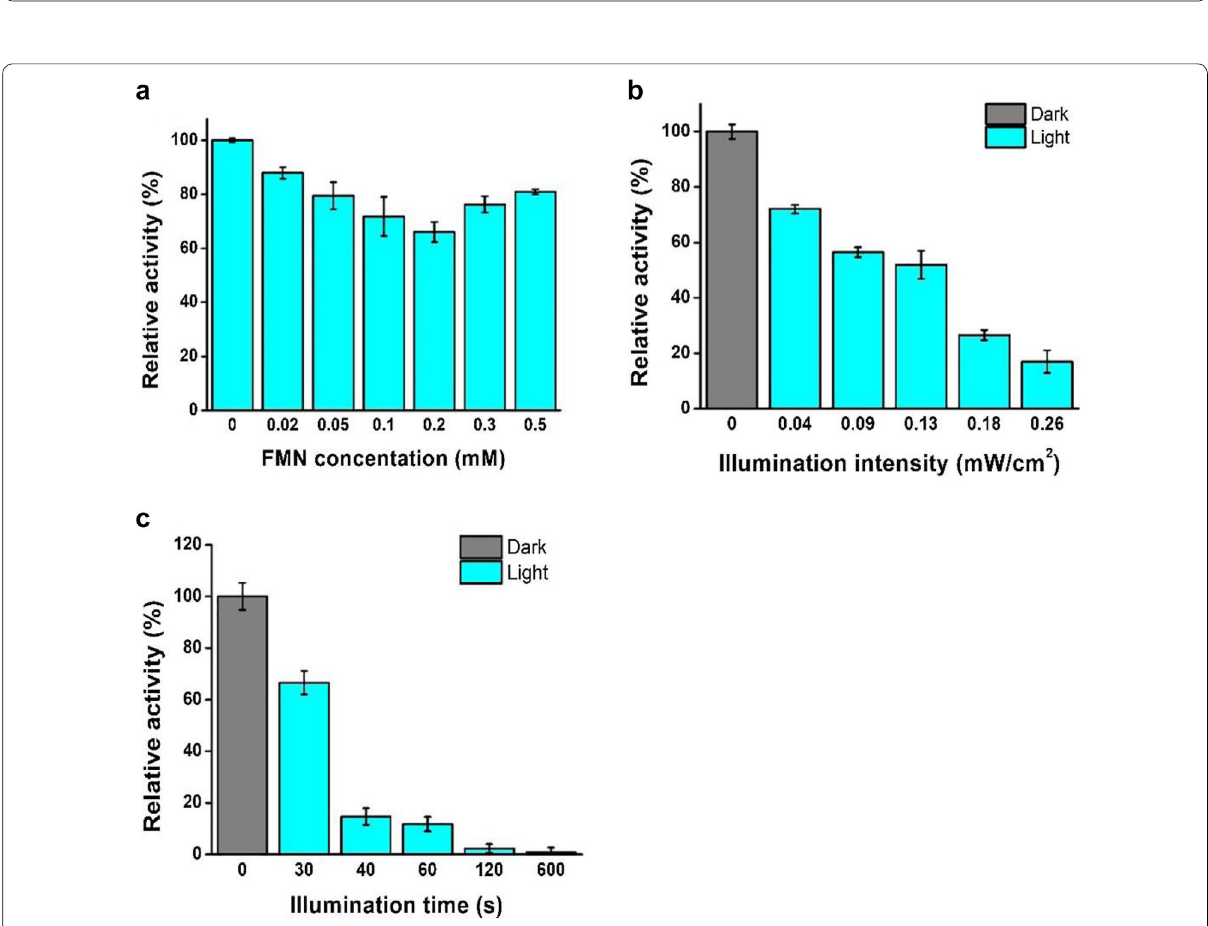
Fig. 3 Optical suppression factors. a Relationship between FMN concentration and the enzyme inhibition under irradiation at 470 nm for the same time. b Power dependency of alov9’s inhibition under illumination at 470 nm for the same time. c Relationship between illumination time and alov9’s inhibition under irradiation at 470 nm. All error bars show SEM ( n =